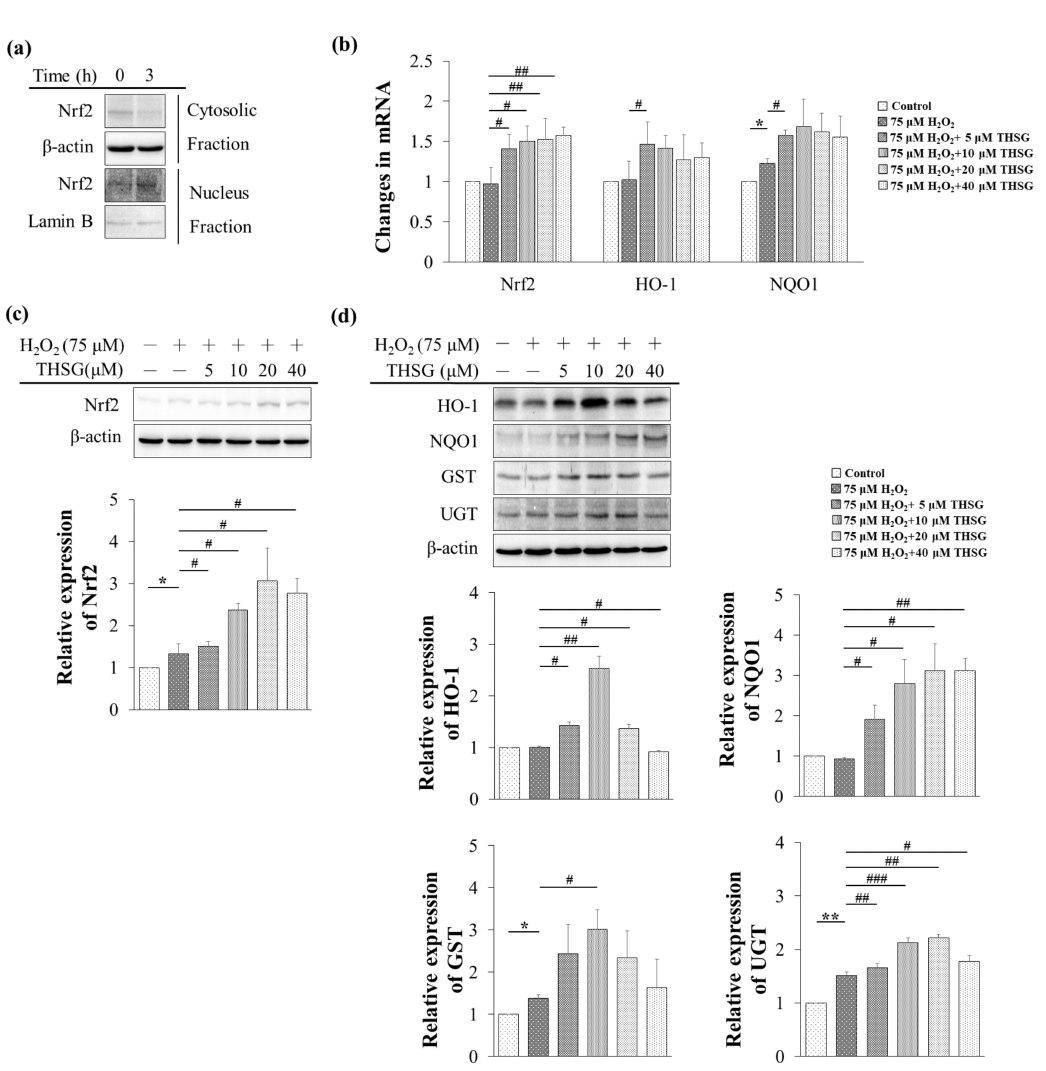
Figure 6. THSG enhances Nrf2 translocation into the nucleus and induces the mRNA and protein expression of antioxidant / detoxifying enzymes under H 2 O 2 -induced oxidative stress conditions. ( a ) The cells were treated with 20 µ M THSG for 3 h, and the protein level of Nrf2 in the cytosolic and nuclear fractions was determined by Western blotting. β -actin was used as a cytoplasmic marker and lamin B was used as a nuclear marker. ( b ) The cells were pretreated with 20 or 40 µ M THSG for 6 h and subsequently stimulated with THSG combined with 75 µ M H 2 O 2 for 6 h, and the mRNA expression levels of Nrf2, heme oxygenase-1 (HO-1), and NAD(P)H:quinone oxidoreductase-1 (NQO1) were measured by real-time PCR. The results of real-time PCR were normalized to GAPDH. ( c ) The cells were pretreated with various concentrations of THSG (5–40 µ M) for 6 h and subsequently stimulated with THSG combined with 75 µ M H 2 O 2 for 24 h, and the cytosolic protein level of Nrf2 was measured by Western blotting. β -actin was used as a cytoplasmic marker. ( d ) The cells were pretreated with various concentrations of THSG (5–40 µ M) for 6 h and subsequently with 75 µ M H 2 O 2 for 24 h, and the protein levels of HO-1, NQO1, glutathione-S-transferase (GST), and UDP-glucuronosyltransferase (UGT) were measured by Western blotting. β -actin was used as the loading control. The results of protein expression were normalized to β -actin. Data are presented as the mean ± SD, n = 3. * p < 0.05 and ** p < 0.01 indicate significant di ff erences from the control group. # p < 0.05, ## p < 0.01, and ### p < 0.001 indicate significant di ff erences from the H 2 O 2 -treated